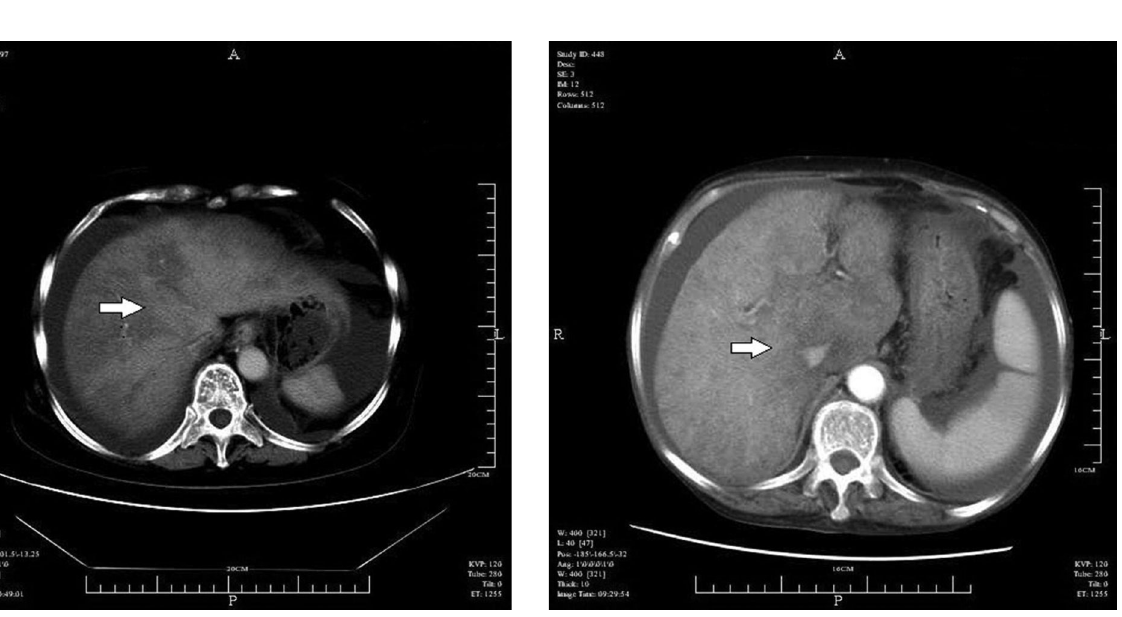
Figure 1. Unenhanced CT image of the liver of a patient with hepatic veno-occlusive disease. The arrow shows the lower geographic liver section, which is slender.